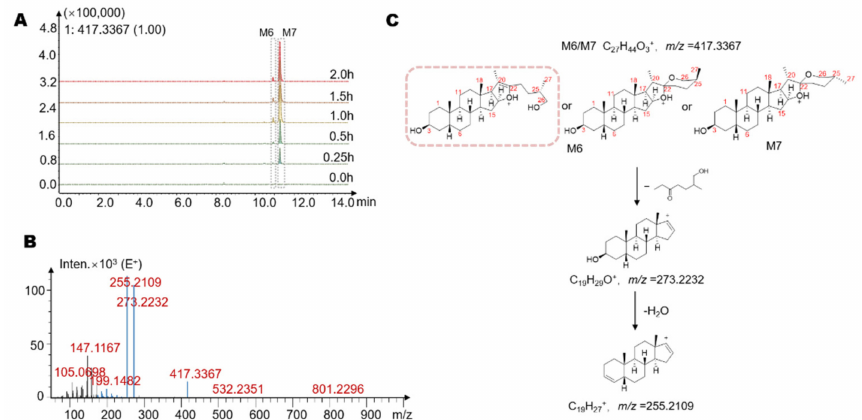
Figure 5. ( A ) The extracted ion chromatograms (EICs) showed that the levels of the possible metabo- lites M6 and M7 increased with increasing time. ( B ) The MS/MS data of the timosaponin BII metabo- lites M6 and M7. ( C ) Possible structures and mass spectrometric cleavage pathway of metabolites M6 and M7. Among them, the structure framed by a rectangle was reported in the gut microbiota for the first